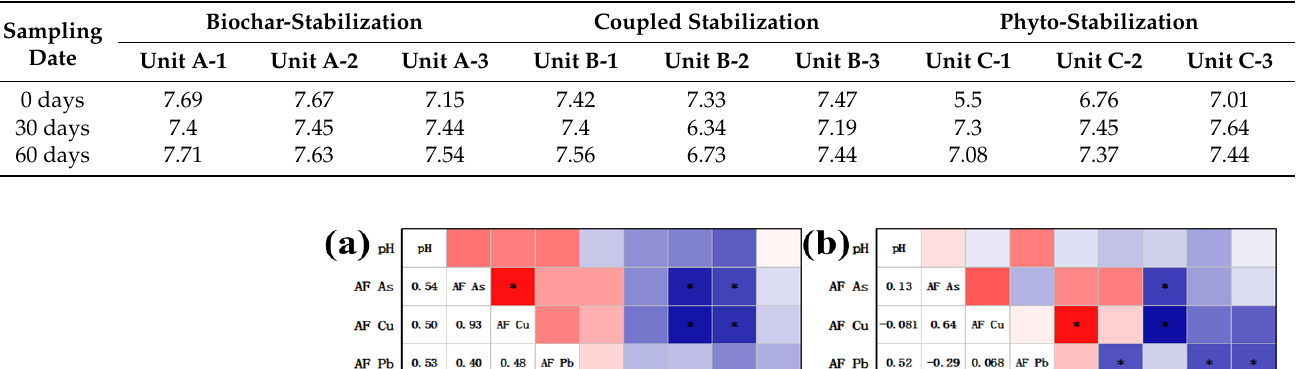
Table 2. Soil pH of all sampling units at 0, 30, and 60 days.